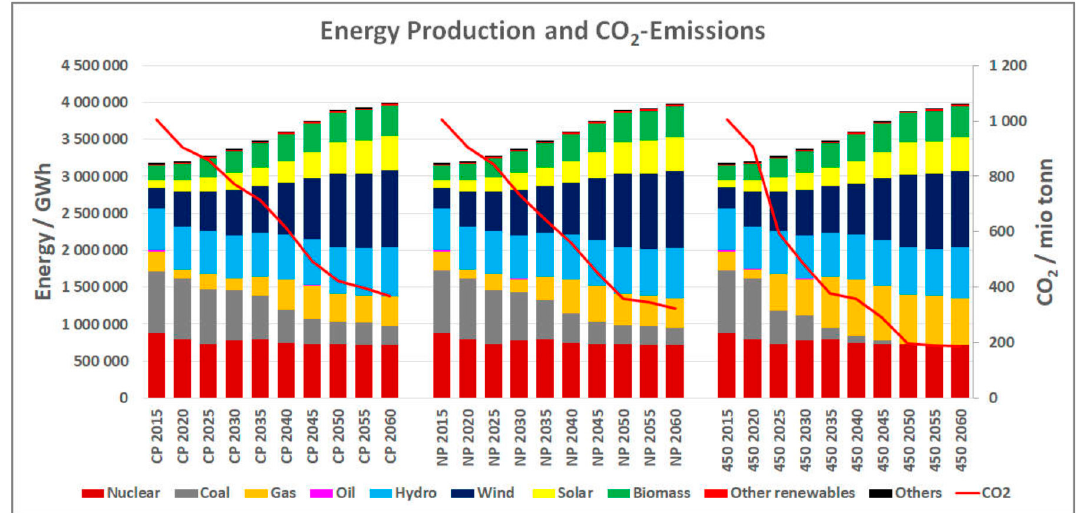
Figure 8. Production mix and CO 2 emissions in the three IEA price-scenarios for the different years.